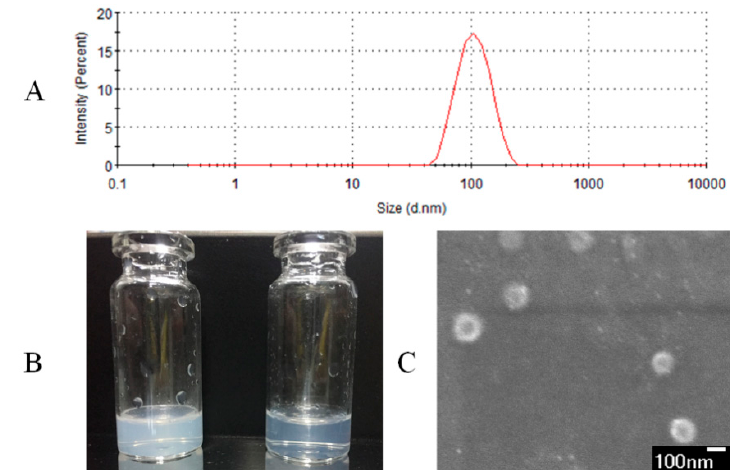
Figure 2. Characterization of vitamin D 3 (VD 3 ) liposomes. ( A ) The particle size of VD 3 liposomes. ( B ) Morphological appearance of VD 3 liposomes at 1 mg/mL and 100 μ g/mL. ( C ) Scanning electron microscope (SEM) of VD 3 liposomes at secondary electron imaging mode (×30,000).